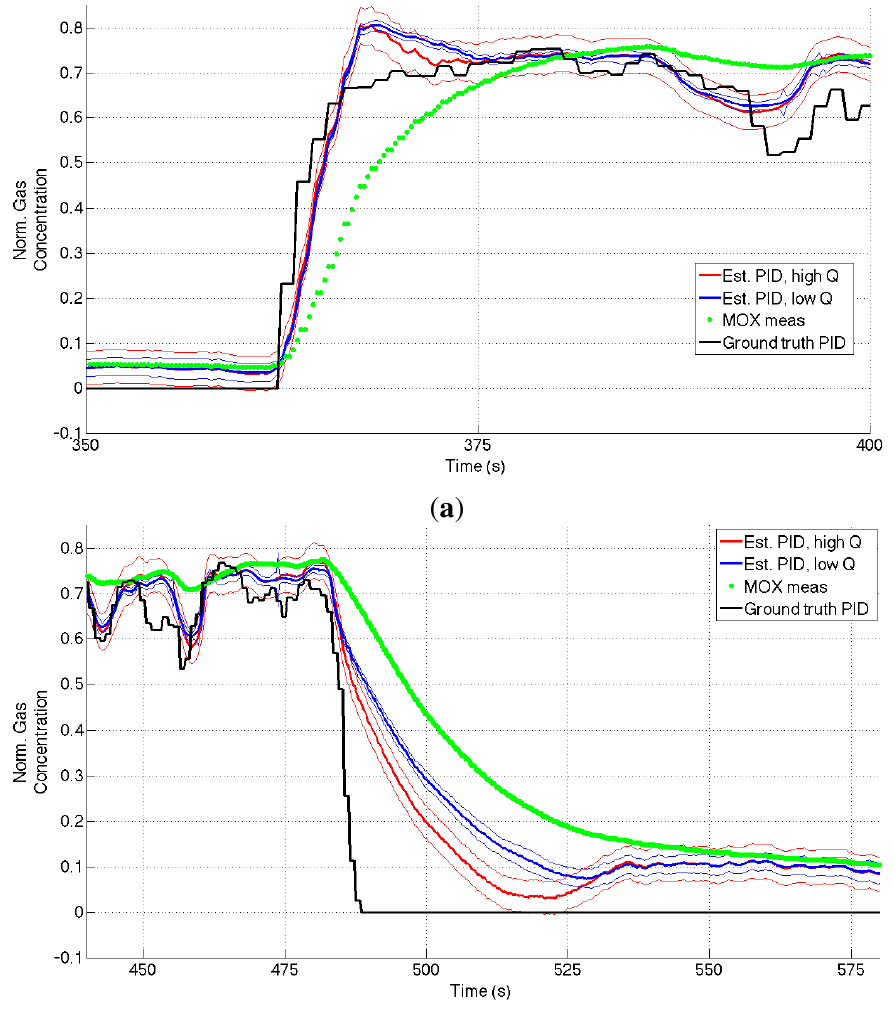
Figure 9. Gas concentration estimation results for rise ( a ), and recovery ( b ) phases of a Steps dataset using different values for the process noise amplitude q . For each color, the thicker line indicates the mean value, the thinner ones the 2 − σ